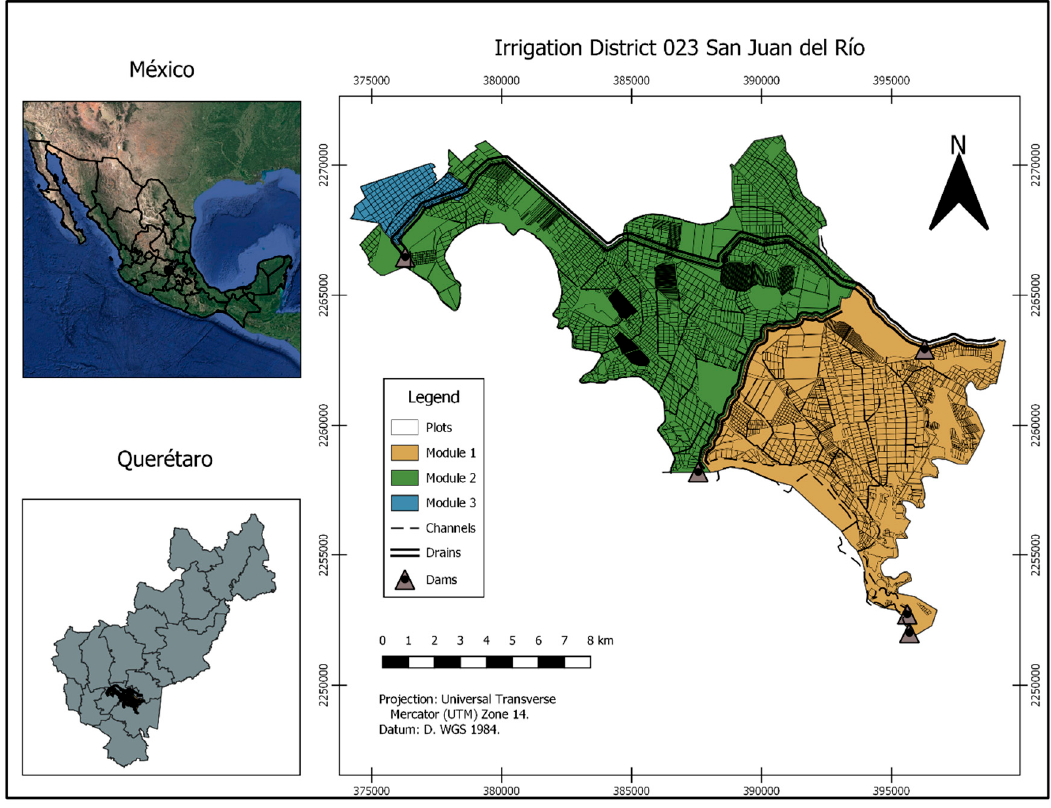
Figure 1. Location map of the Irrigation District 023 San Juan del Río Querétaro.